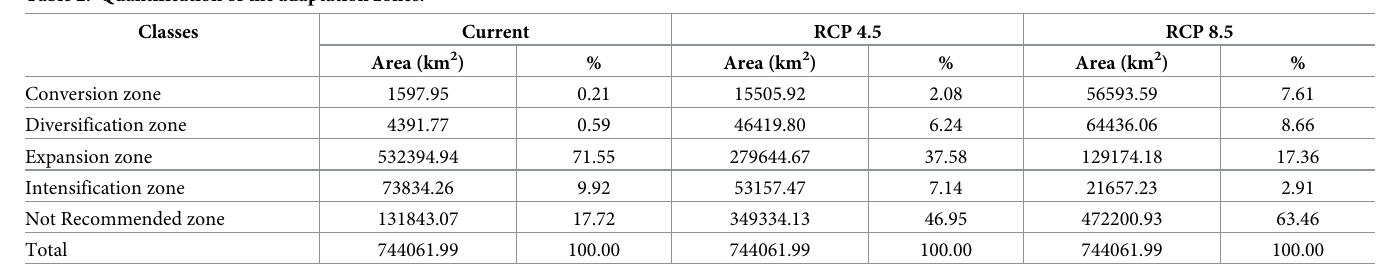
Table 2. Quantification of the adaptation